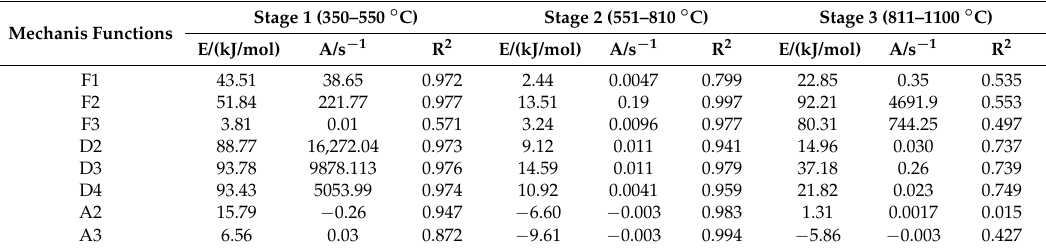
Table 7. Kinetic parameters of the JM briquette using different mechanism functions.